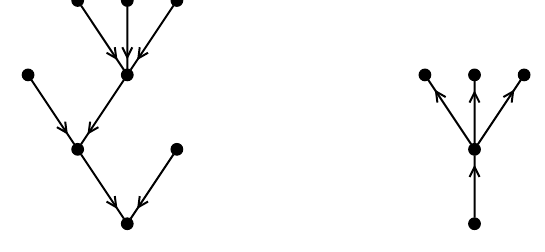
Figure 15: An in-tree and an out-tree.